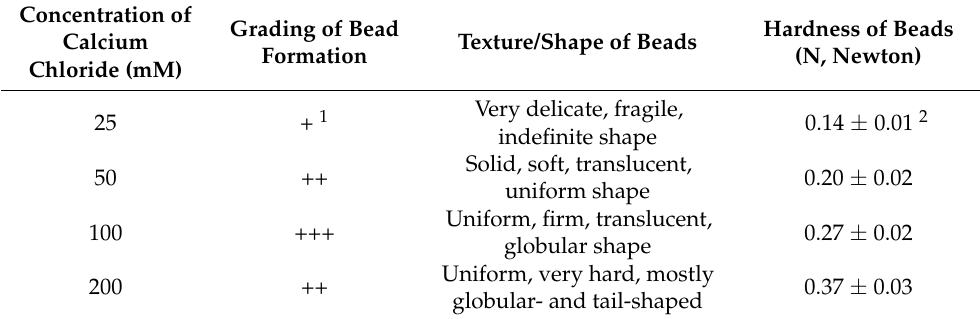
Table 2. Effect of different concentrations of calcium chloride (CaCl 2. 2H 2 O), used with 2.5% sodium alginate, on bead morphology and hardness of G. jasminoides